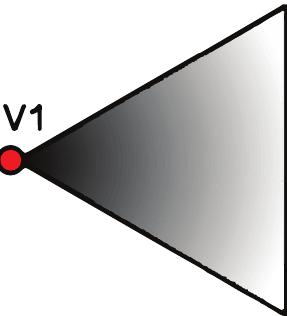
Figure 6. Content quality assuming sharpness continuous variation.